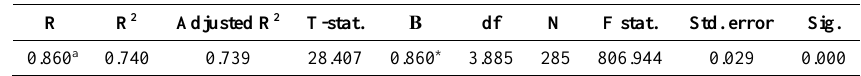
Table 4. Hypothesis three result